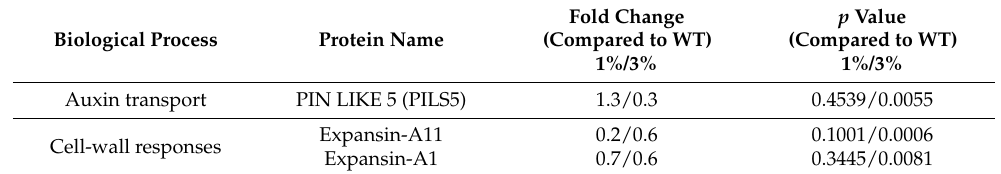
Table 3. Selected proteins downregulated in roots of atg5-1 seedlings under different sucrose treatments. Biological Process